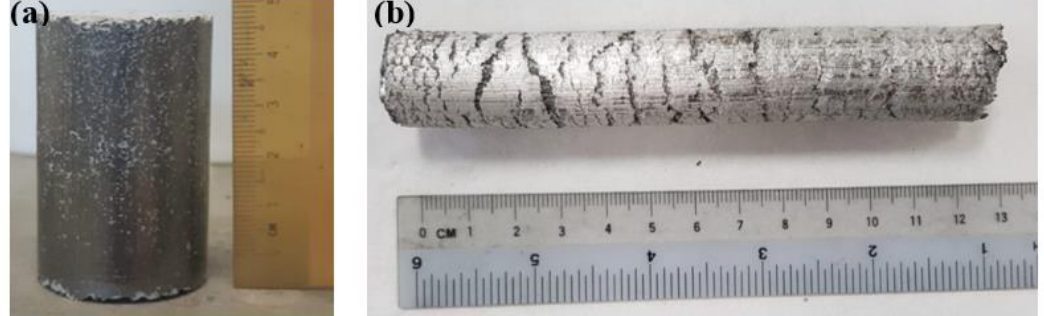
Figure 1. ( a ) Compacted billet and ( b ) extruded rod of Mg-20GMB syntactic composite core